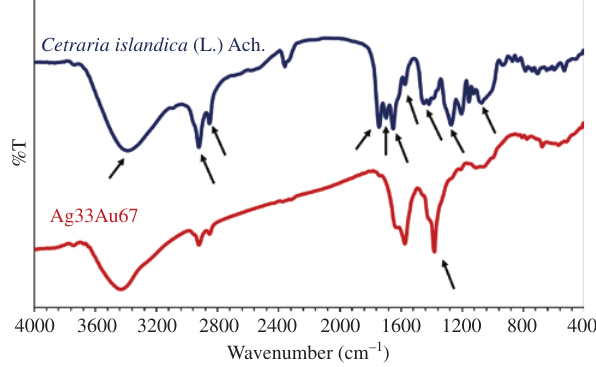
Figure 4: Fourier transform infrared (FTIR) spectra of dried Cetraria islandica (L.) Ach. extract and Ag33Au67